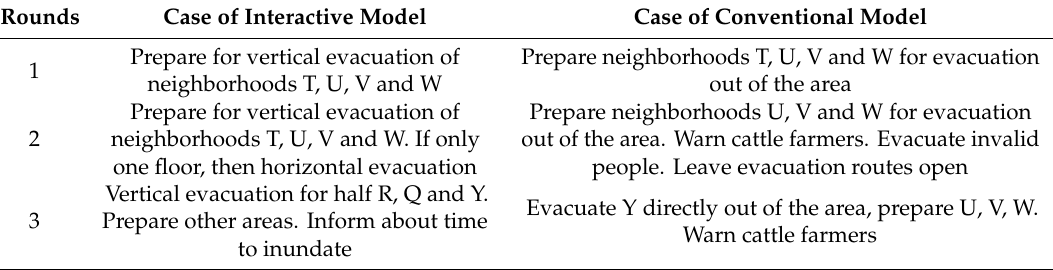
Table 5. The follow-up actions that were decided upon after each round with and without the use of an interactive model. The letters of the neighborhoods correspond to the topographical map that was available in both cases (see Figure 3).